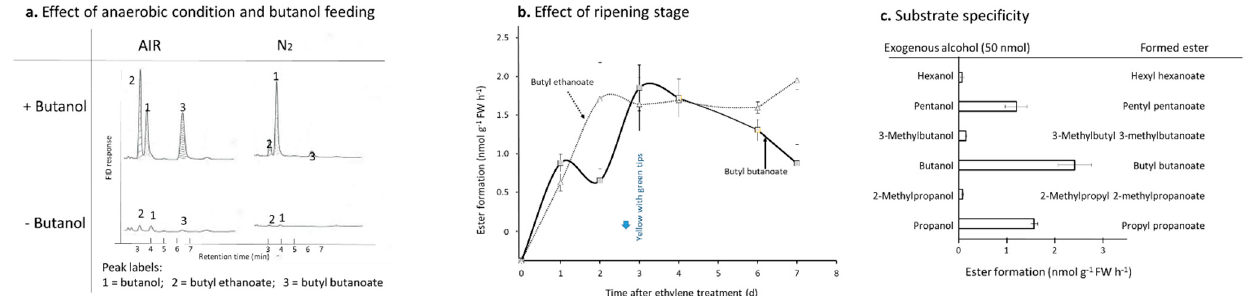
Figure 3. Alcohol feeding experiments and production of corresponding esters in banana pulps. Exogenous alcohol (50 µmol) on filter paper was fed into 10 g of banana pulp tissues. ( a ) Effect of anaerobic conditions and butanol feeding to pulps at the “yellow with green tips” stage; ( b ) effect of ripening stage; ( c ) substrate specificity of C3–C6 branched and straight chain alcohols at the “yellow with green tips” stage. Vertical/horizontal line at each marker/column shows average ± SD (n = 3).